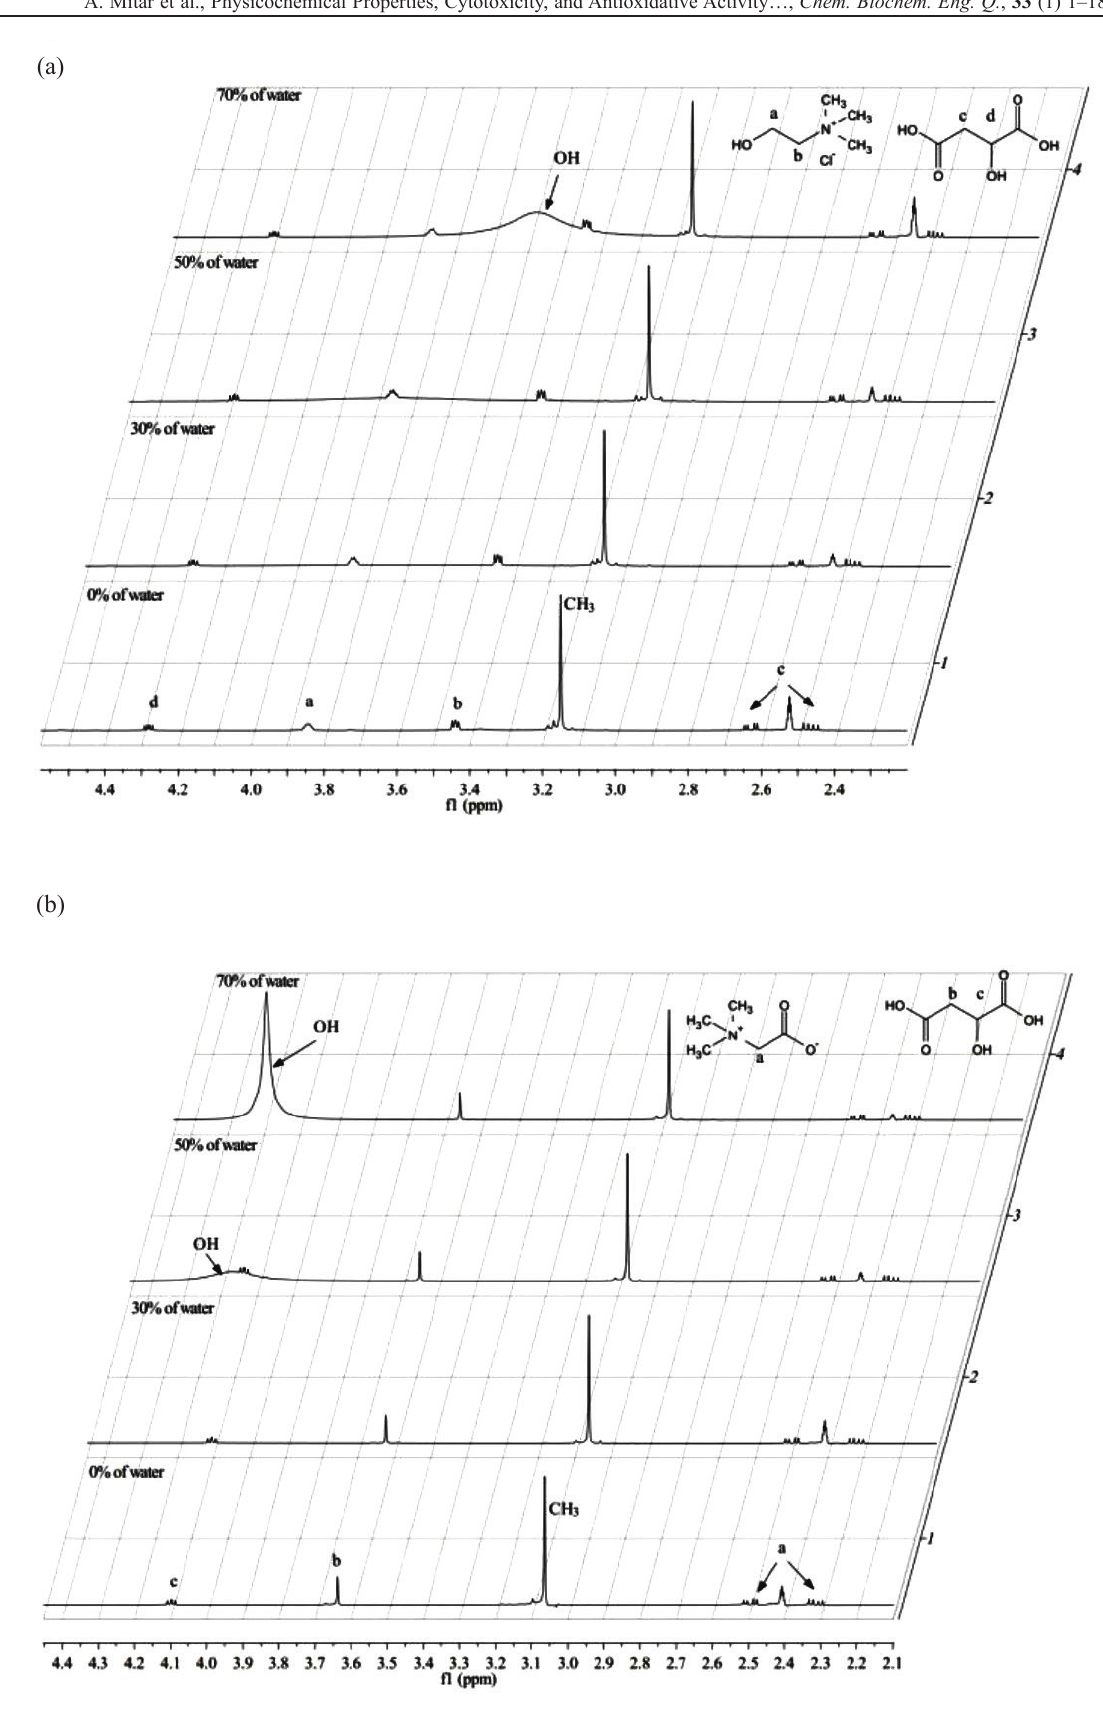
Fig. 2 – NMR spectra of ChMa (a) and BMa (b) prepared with different amounts of water (0 to 70 % by